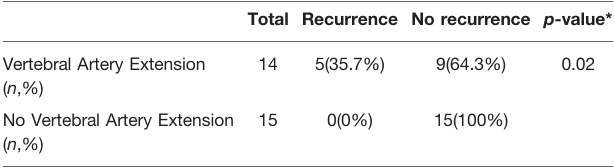
TABLE 5 | Vertebral artery extension of recurrence